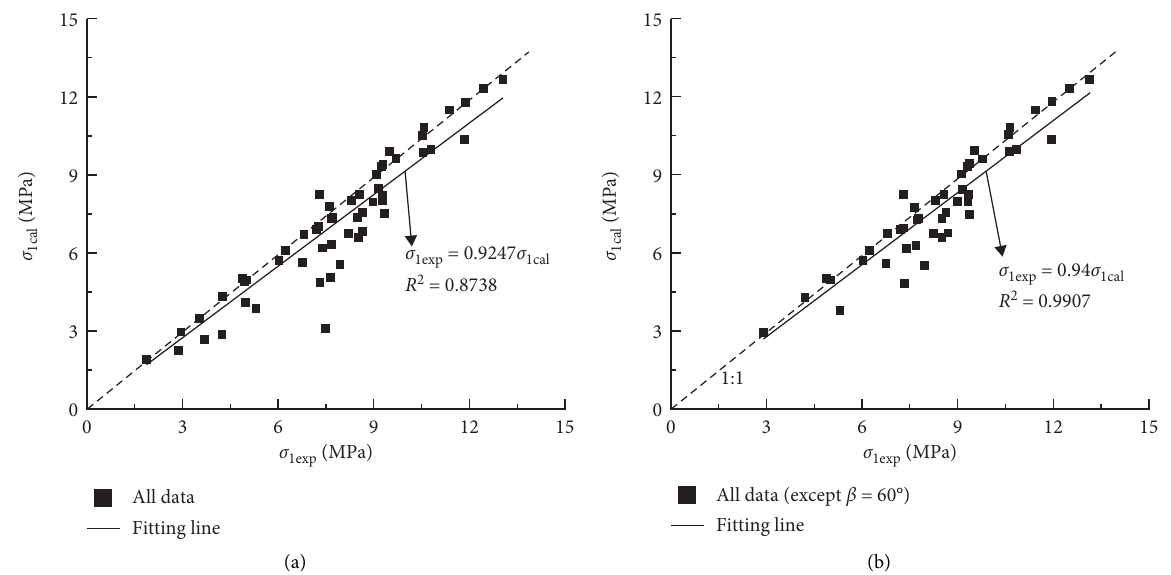
Figure 7: The fitting results of all the experimental strength of jointed blocky mass: (a) all the data and (b) all the data except β � 60 ° . Table 4: Percentage error in predicting strength data of rock mass models. σ 3 (MPa) σ 2